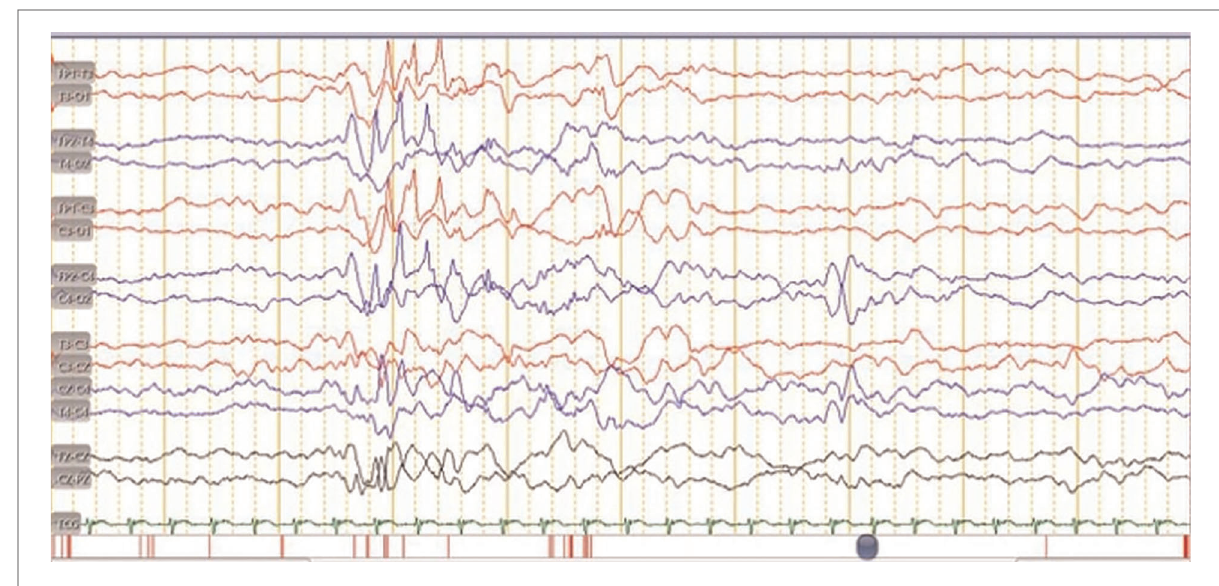
FIGURE 2 EEG in a month-old male with congenital disseminated TB showed there was an electrical